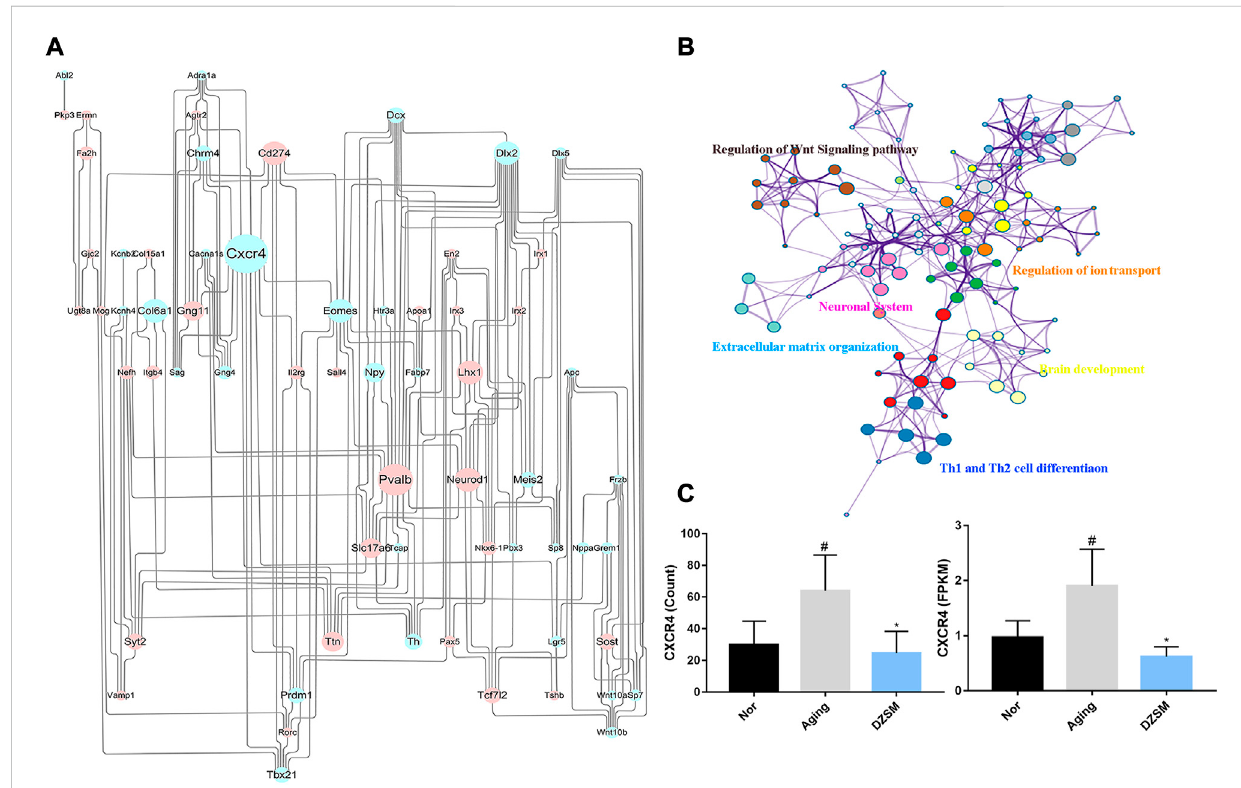
FIGURE 4 Network analysis of reverse DEGs. (A) The network of DEGs in the Aging and DZSM groups. Upregulated/downregulated DEGs are indicated by the blue/pinknodeswhosesizere fl ectsthedegree. (B) GOtermsforthenetworkofreverseDEGs. (C) TheexpressionlevelsofCXCR4inRNA-seq(compared with the Nor group: # p < 0.05, ## p < 0.01; compared with the Aging group: * p < 0.05, ** p <